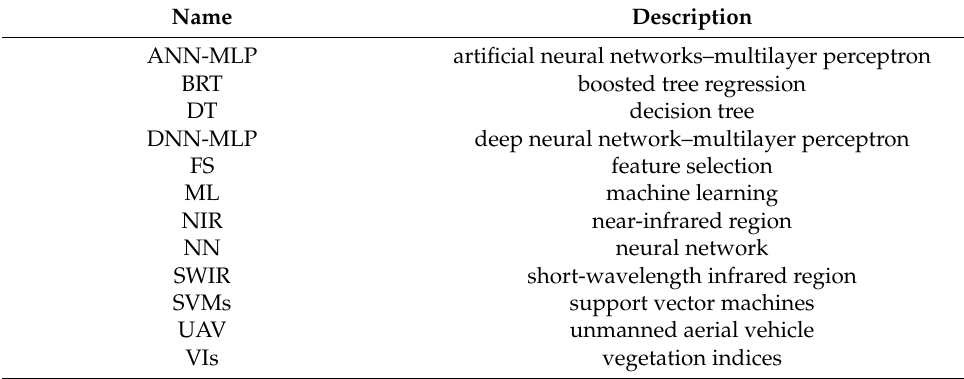
Table 1. Description of the abbreviations.